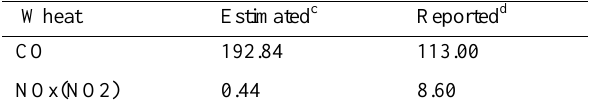
Table 9b. Comparison of the estimated total emissions with reported total emissions of GHGs in 2005 during wheat straw burning in Punjab. c Estimation for the year 2005 (during wheat straw burning). d Estimates of wheat straw burning 2005 (Badarinath et al., Figure 8. Total emissions of GHG and aerosol during open field combustion of rice (2002-11) and wheat (2003-12) straw in Punjab.